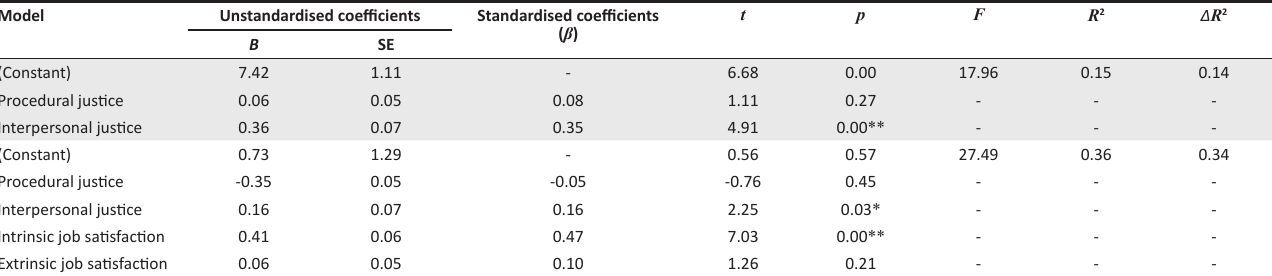
TABLE 5: Multiple regression analysis with employee engagement (work energy) being the dependent variable and procedural justice, interpersonal justice, intrinsic job satisfaction and extrinsic job satisfaction the independent variables. Model